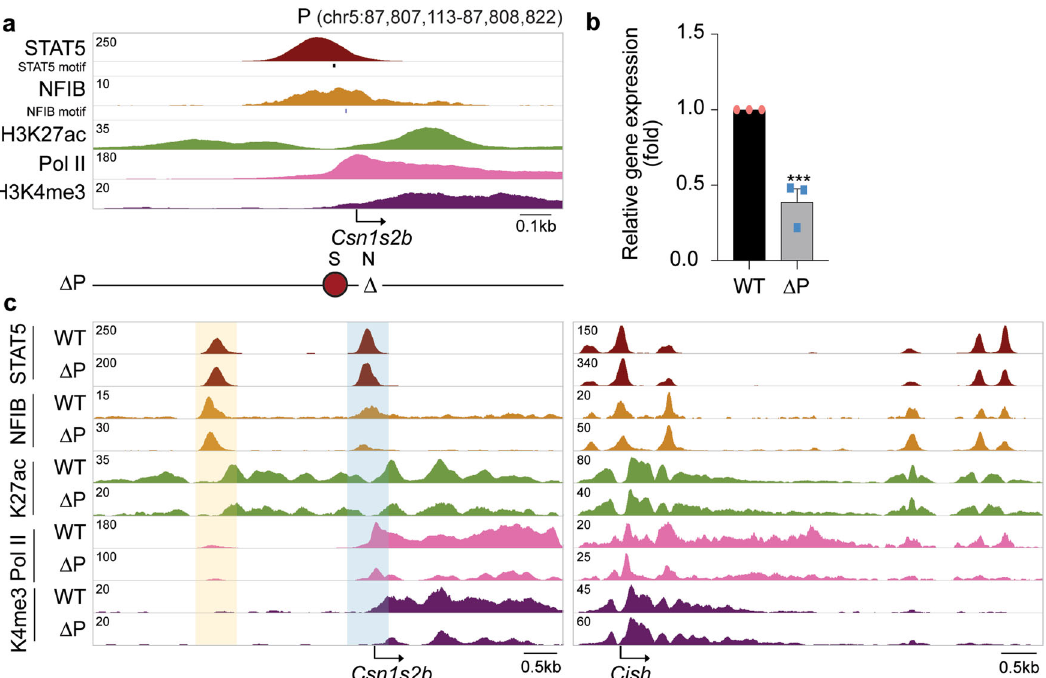
Fig. 6 The NFIB site in the Csn1s2b promoter modulates gene activity. a Genomic feature of the Csn1s2b promoter region in mammary tissue at day ten of lactation. Δ P, deletion of the NFIB motif. b mRNA levels of Csn1s2b gene were measured by qRT-PCR in L1 mammary tissue from WT and Δ P mutant mice and normalized to Gapdh levels. Results are shown as the means ± s.e.m. of independent biological replicates ( n = 3). Unpaired two-tailed t-test was used to evaluate the statistical signi fi cance of differences. p -value = 0.002 c The consequences of super-enhancer deletion were con fi rmed by ChIP-seq analysis in WT and mutant tissues at L10. The Cish locus served as a ChIP-seq control.